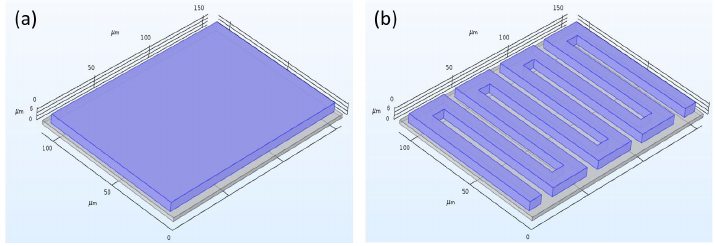
Figure 2. Thermistor shapes ( a ) Rectangular; ( b )